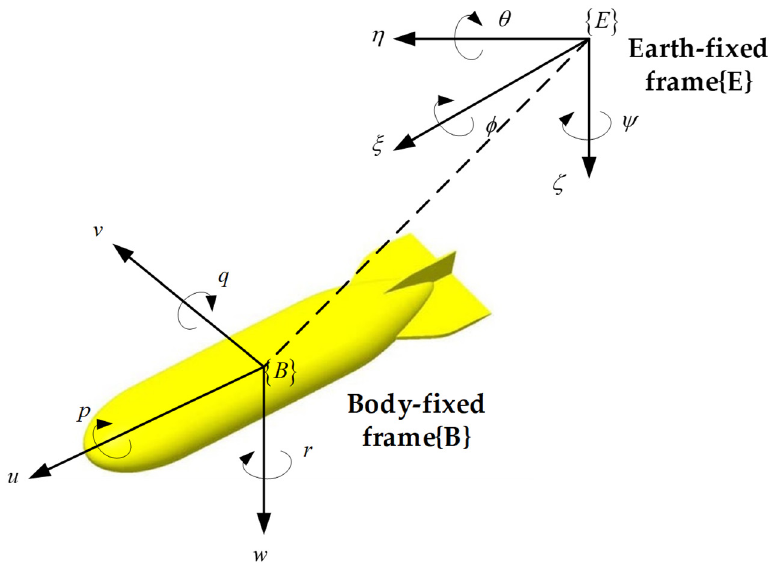
Figure 1. Coordinate system of a UUV.